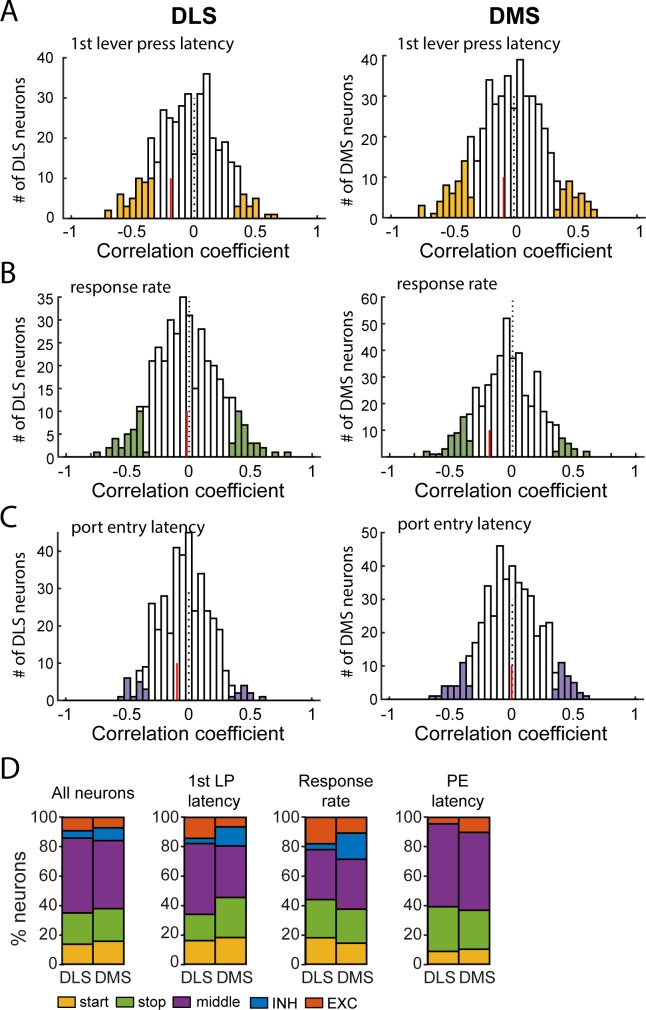
Comparison of correlations relating neural firing rate and behavior in DMS and DLS.(A) Distribution of Spearman rank correlation coefficients relating firing rate after lever insertion (0–500 ms) to the first lever press latency, in DLS (left) and DMS (right) neurons. (B) Distribution of Spearman rank correlation coefficients relating firing rate during lever presses to the response rate in DLS (left) and DMS (right) neurons. (C) Distribution of Spearman rank correlation coefficients relating firing rate after lever retraction (0–500 ms) to the port entry latency in DLS (left) and DMS (right) neurons. In each graph, the vertical red line indicates the median correlation coefficient of correlated units. (D) Proportion of neurons per class in DMS and DLS in the whole population of recorded neurons (left), and in populations of neurons correlated with the 1st lever press latency (middle left), the response rate (middle right), and the port entry latency (right).